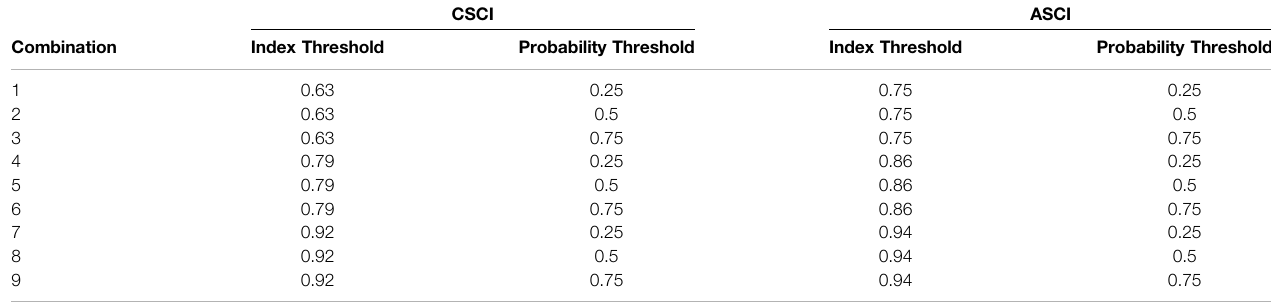
TABLE 2 | Threshold combinations ( n (cid:1) 9) for CSCI and ASCI. Each combination consists of one index threshold and one probability threshold.